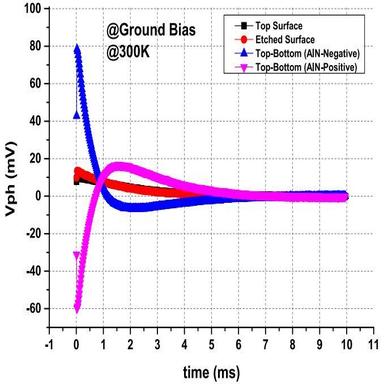
TPV measurements of AlN stack.